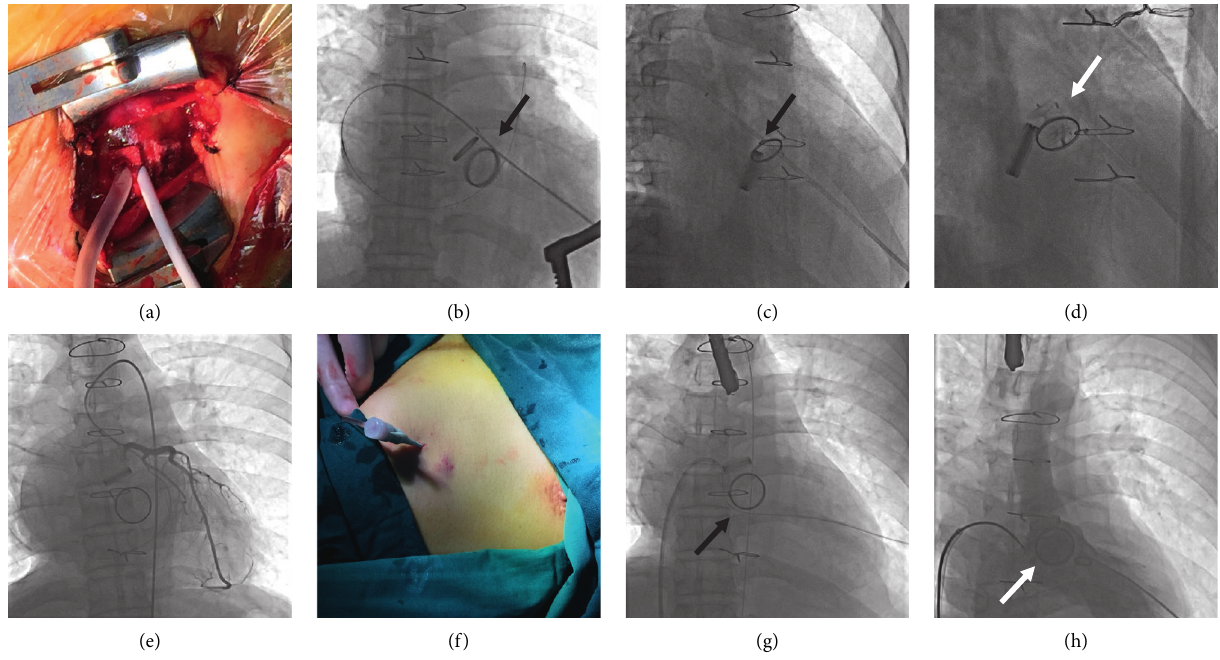
Figure 5: Closure of a mitral paravalvular leak (PVL) via the transapical approach. (a–d) The transcatheter closure of the mitral PVL via a minimally invasive transapical approach. (a) The transapical accesses were obtained by placement of a 6 Fr sheath. (b) The mitral PVL was crossed retrogradely. (c) The introducer sheath was advanced into the left atrium. (d) The occluder was deployed. (e–h) Transcatheter closure of the mitral PVL via a transapical puncture and arteriovenous loop. (e) Coronary angiogram to confirm the location of the left anterior descending artery. (f) A 5 Fr sheath was placed into the left ventricle percutaneously. (g) The transseptal puncture was followed by snaring the wire to establish an arteriovenous loop. (h) The occluder was placed at the position of the PVL followed by a left ventricular angiogram. The black arrow indicates the PVL. The white arrow indicates the